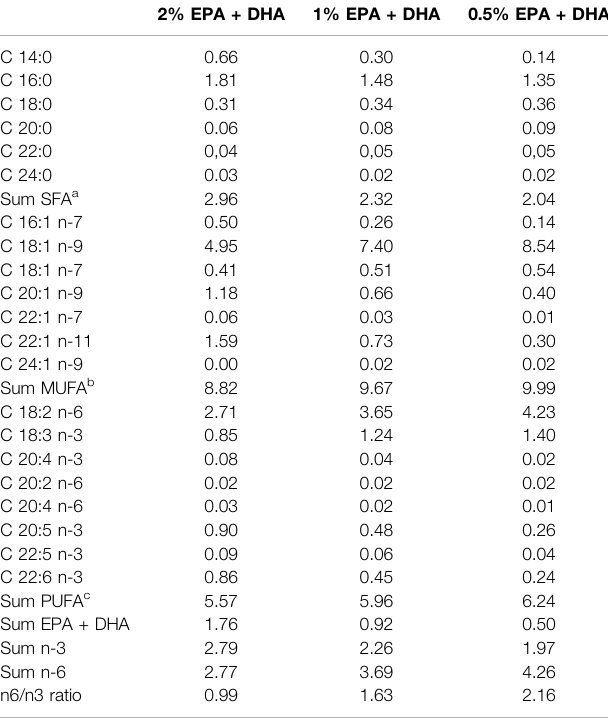
TABLE 2 | Fatty acid content in experimental diets, g p 100 g − 1